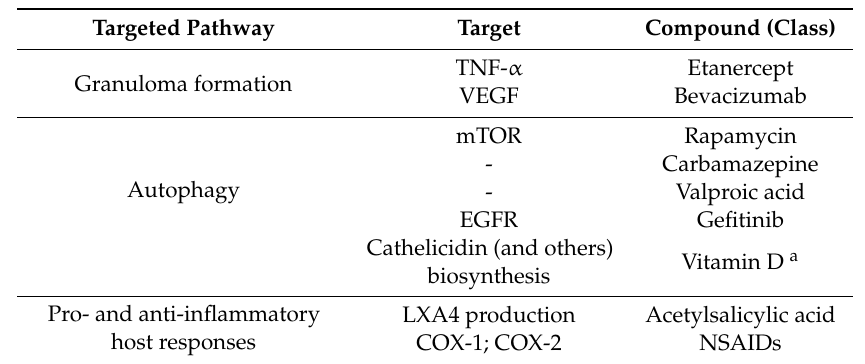
Table 3. HDT-related target examples and their relevant compounds or compound